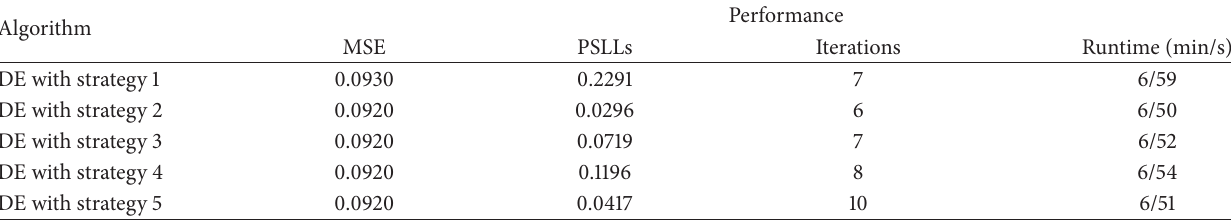
Table 2: Comparison of different strategies.